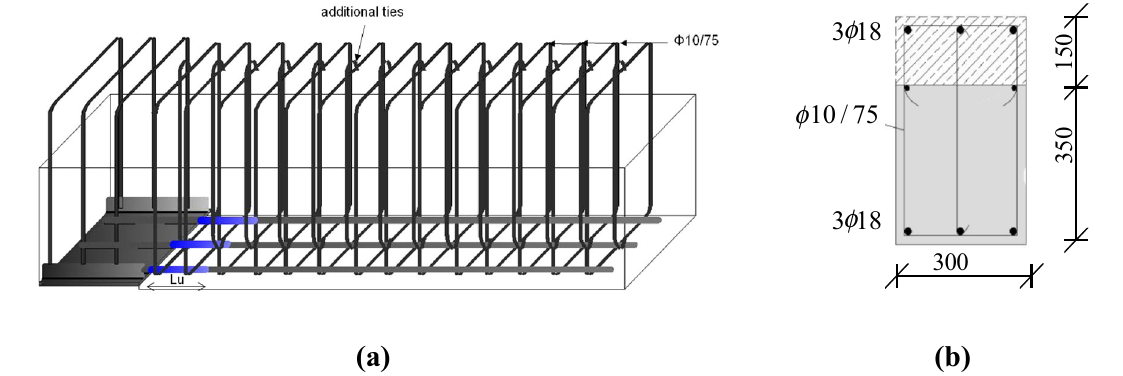
Fig. 9 a Application of unbounded length and b beam cross-section details of SP3-R specimen.